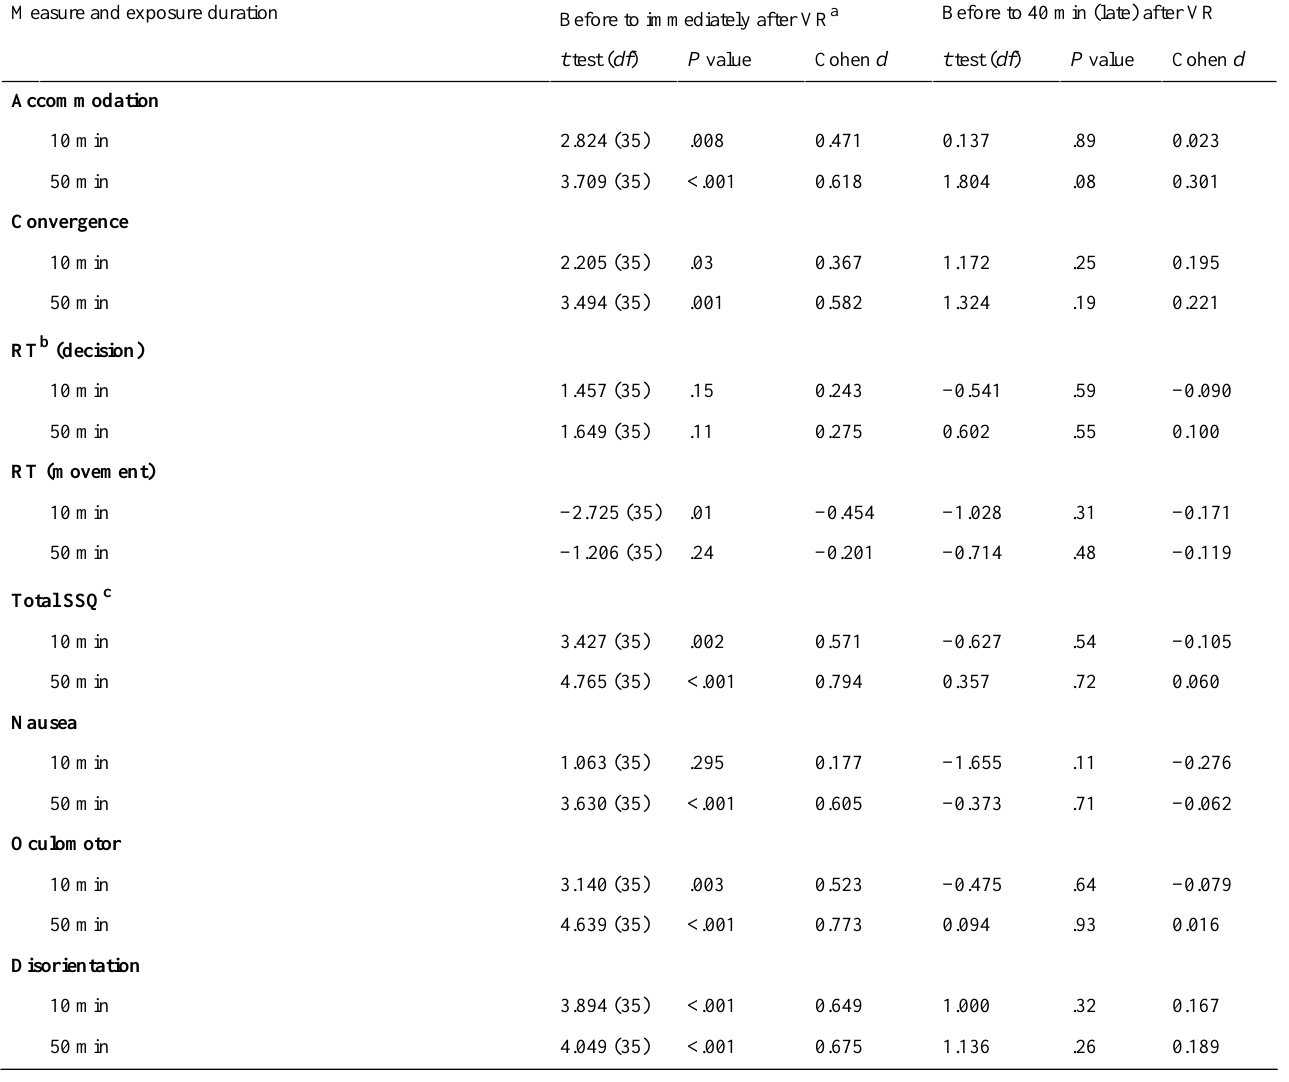
Table 1. One-sample t tests summarizing the measures that are significantly different from zero (baseline) for both test periods (immediate and late) and exposure